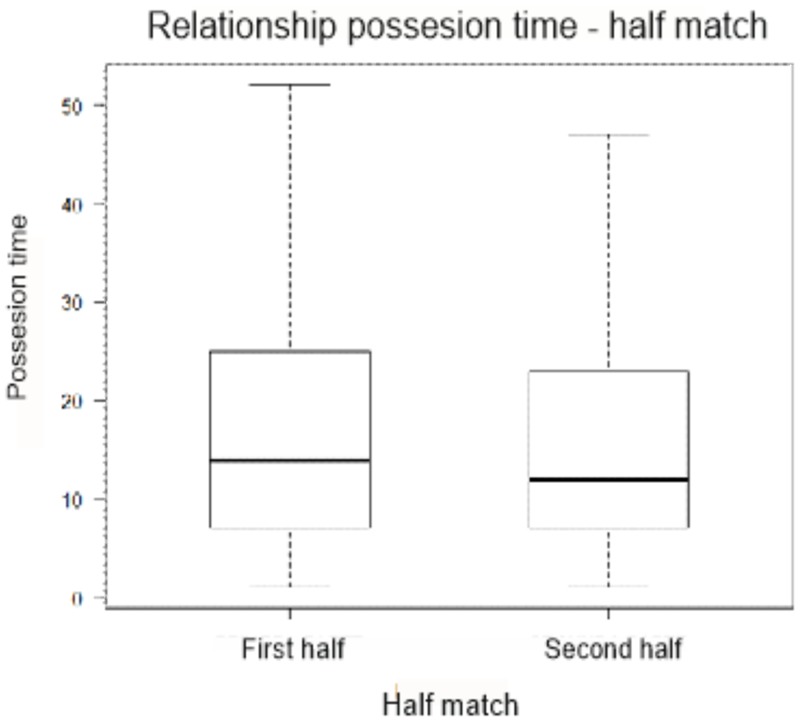
Half match and possession time diagram box.